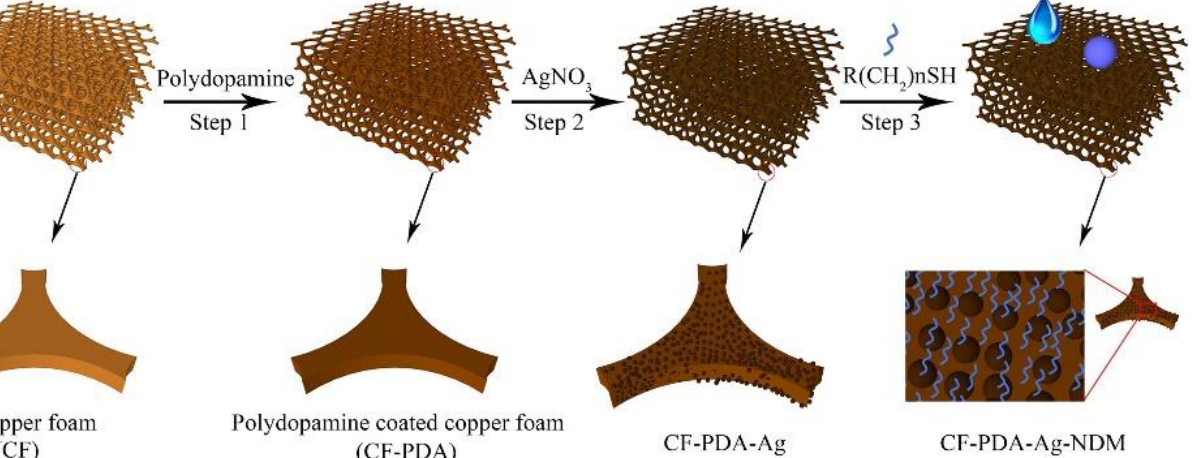
Figure 2. Fabrication of a superhydrophobic surface using copper foam as a substrate. Reprinted from Applied Surface Science, Vol 413, Wei Zhou, Guangji Li, Liying Wang, Zhifeng Chen, Yinlei Lin, “A facile method for the fabrication of a superhydrophobic polydopamine -coated copper foam for oil/water separation”, Pages No.140, Copyright (2017), with permission from Elsevier [42].